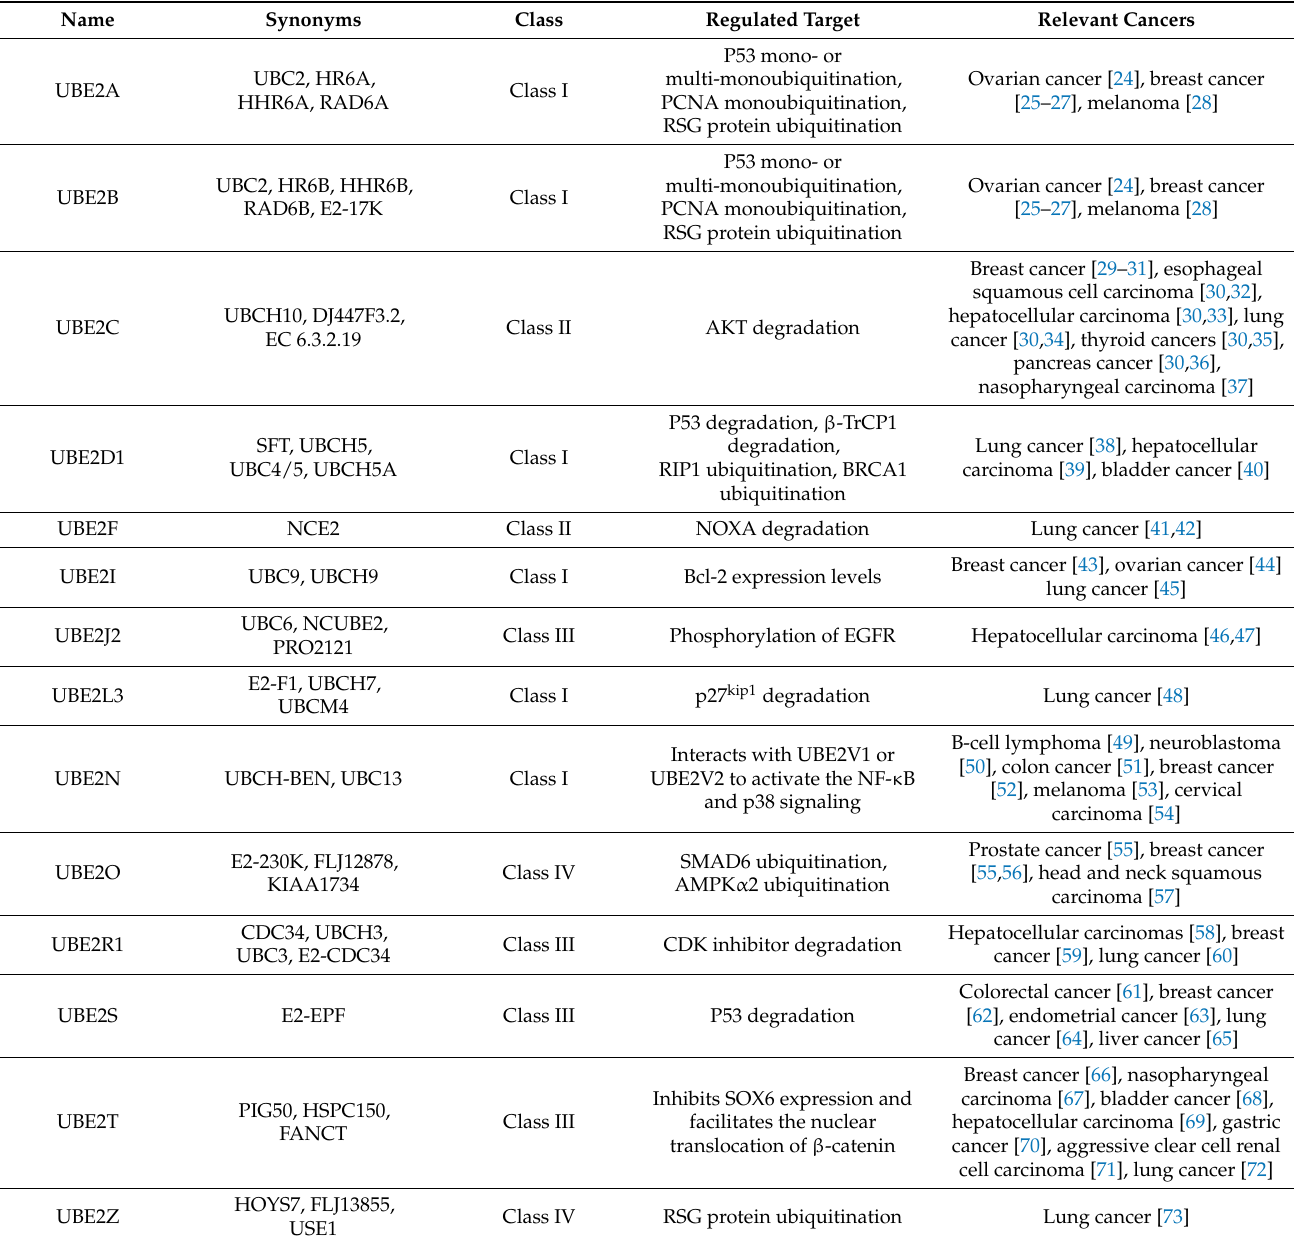
Table 1. E2 enzymes and their association with